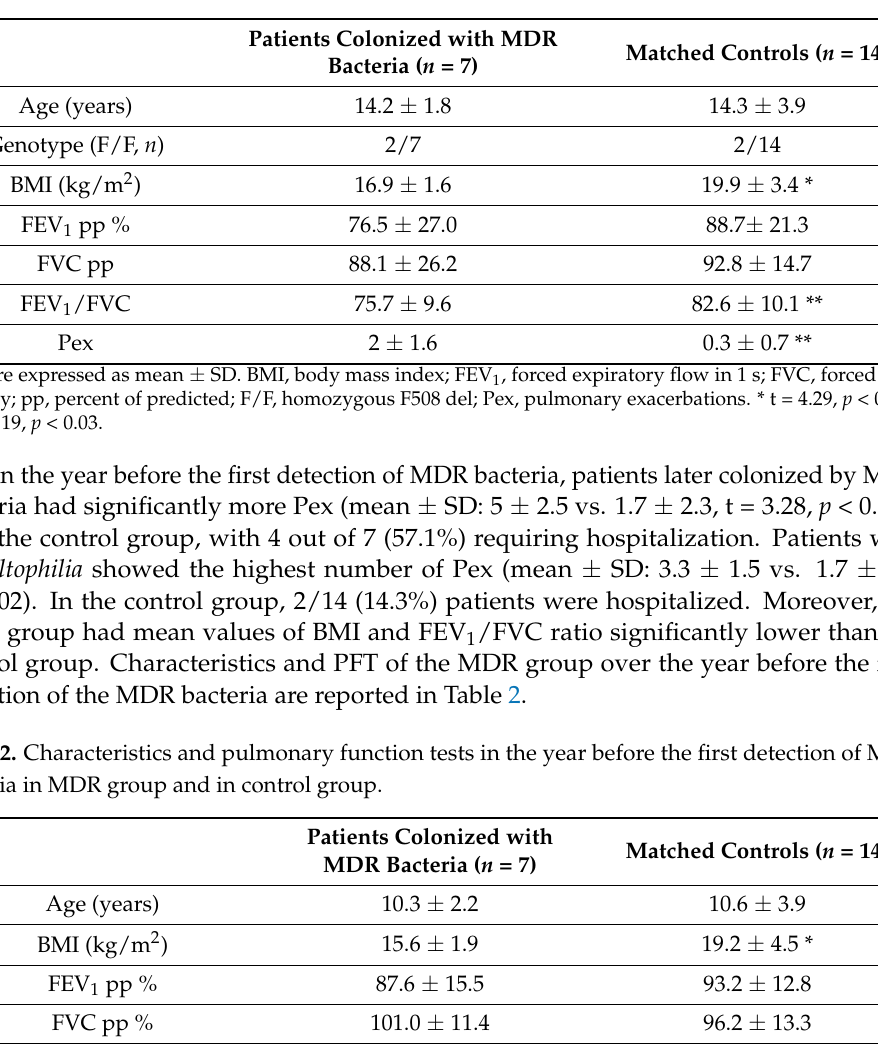
Table 1. Characteristics and pulmonary function tests at time of data collection in patients with CF colonized by MDR bacteria and in control group.